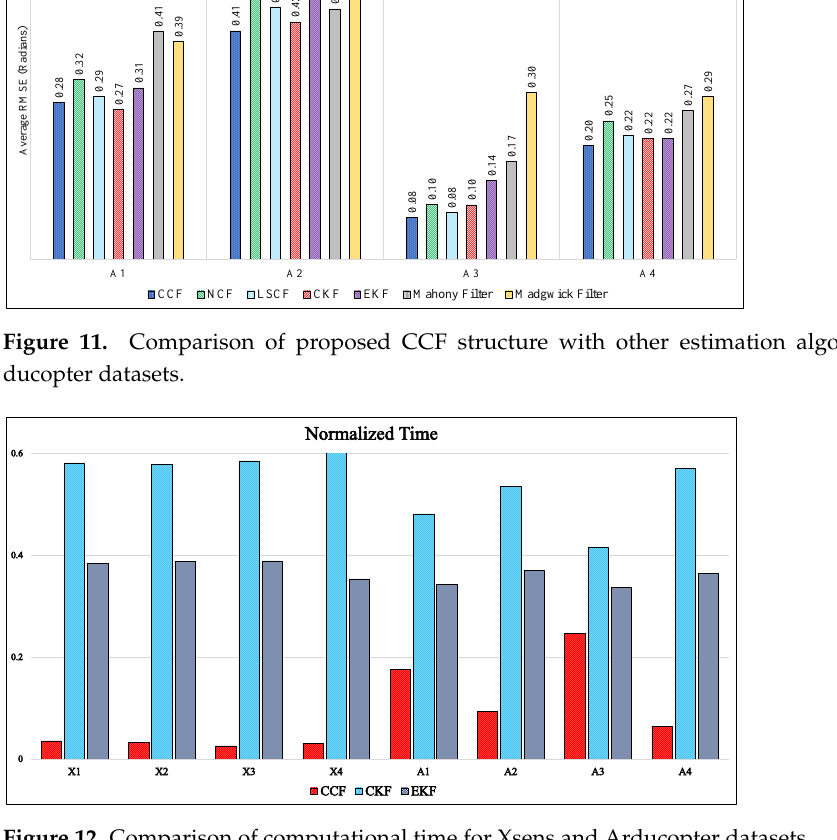
Figure 12. Comparison of computational time for Xsens and Arducopter datasets. Table 4. Considered parameter values for different